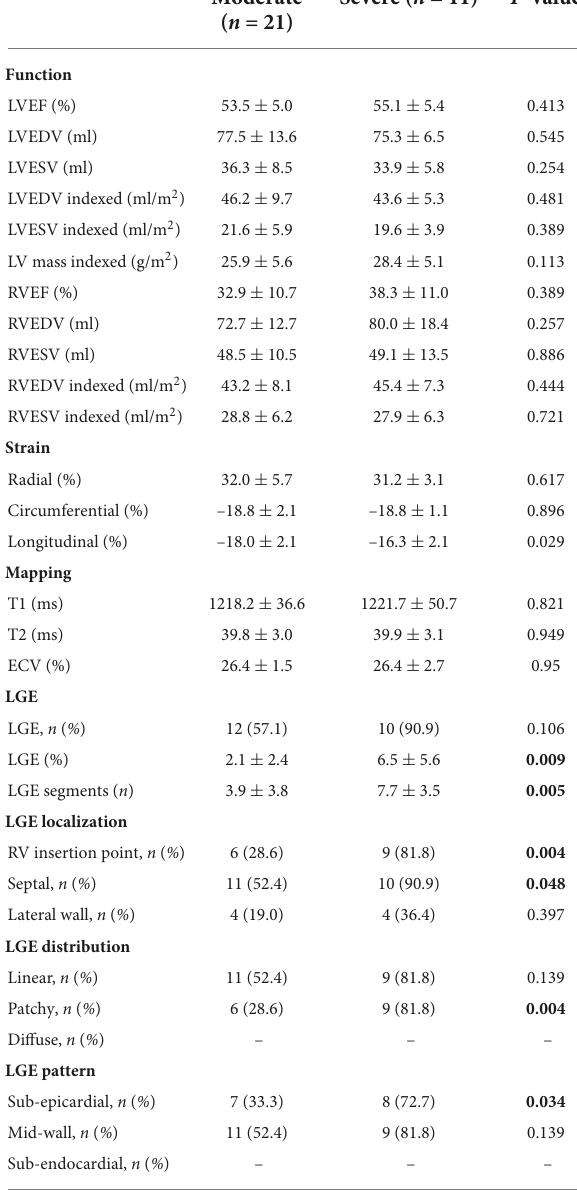
TABLE 3 Cardiovascular magnetic resonance (CMR) imaging findings of moderate and severe